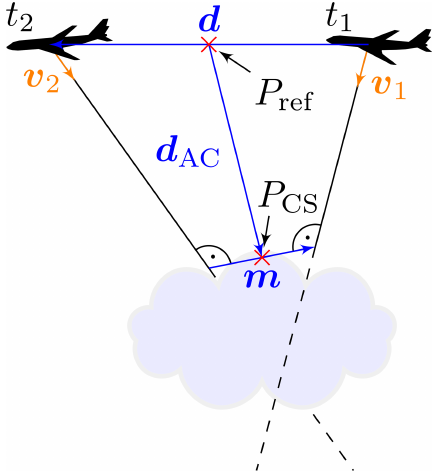
Figure 1. Schematic drawing of the stereographic geometry. Im- ages of clouds are taken at two different times from a fast-moving aircraft. Using aircraft location and viewing geometry, a point P CS on the clouds surface can be calculated. Note that the drawing is not to scale: d is typically around 200m, d AC is on the order of 5km and m denotes the mis-pointing vector and is on the order of only a few